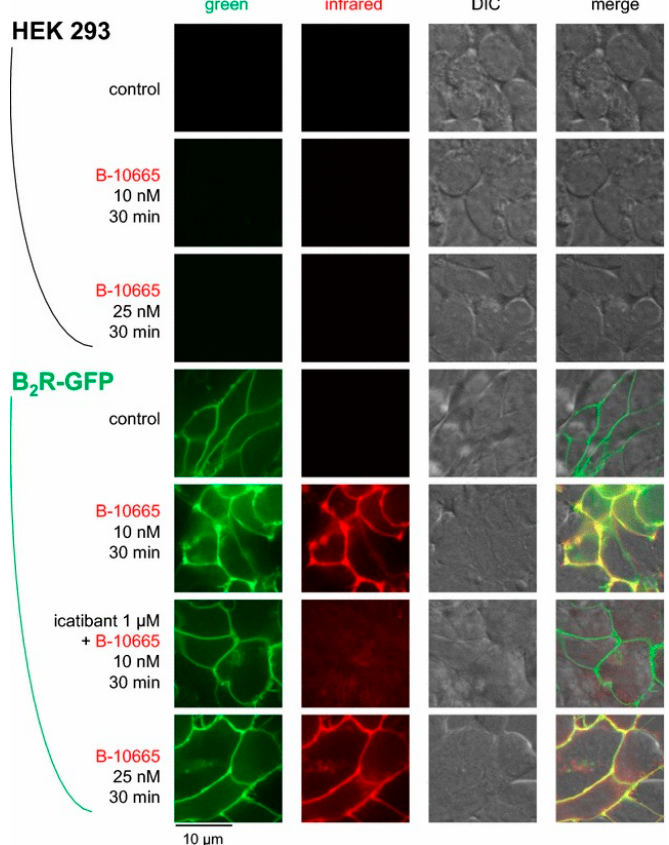
Figure 10. Near-infrared imaging of B2R. Imaging of HEK 293a cells expressing B2R-GFP using Cy7-conjugated B-10665 (infrared fluorescence rendered as red false color). Labelling was performed for 30 min at 37 °C, followed by rinse. Original magnification 95×. Figure reproduced with permission from Infrared-emitting, peptidase-resistant fluorescent ligands of the bradykinin B2 receptor: